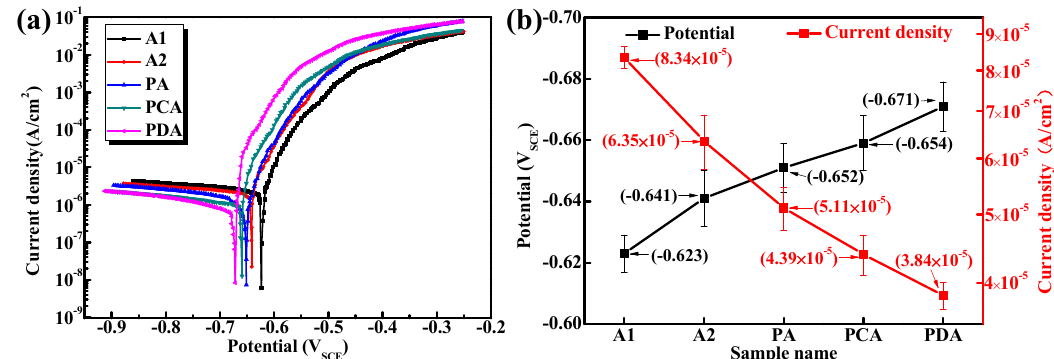
Figure 2. ( a ) Potentiodynamic polarization curves of the five aged samples during immersion in 3.5 wt% NaCl solution; ( b ) The values of corrosion potential (E corr ) and corrosion current density (I corr ).